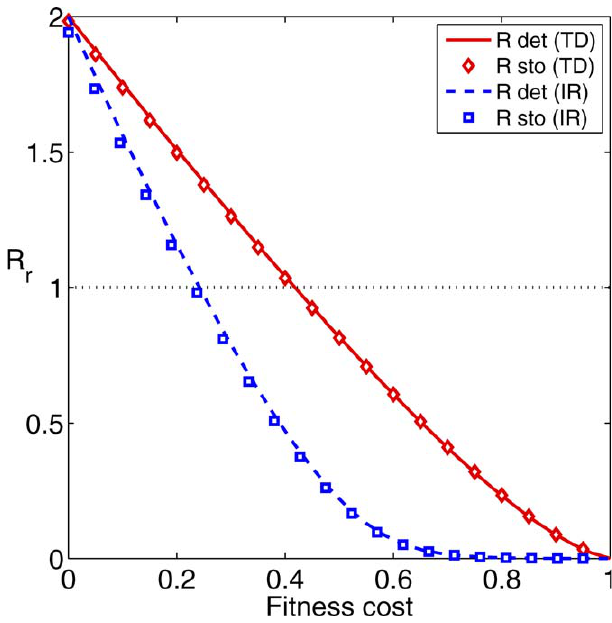
Figure 5. Spread of Resistance as Measured by R r Note that only variation in the fitness cost has an impact on R r since treatment does not affect the resistant